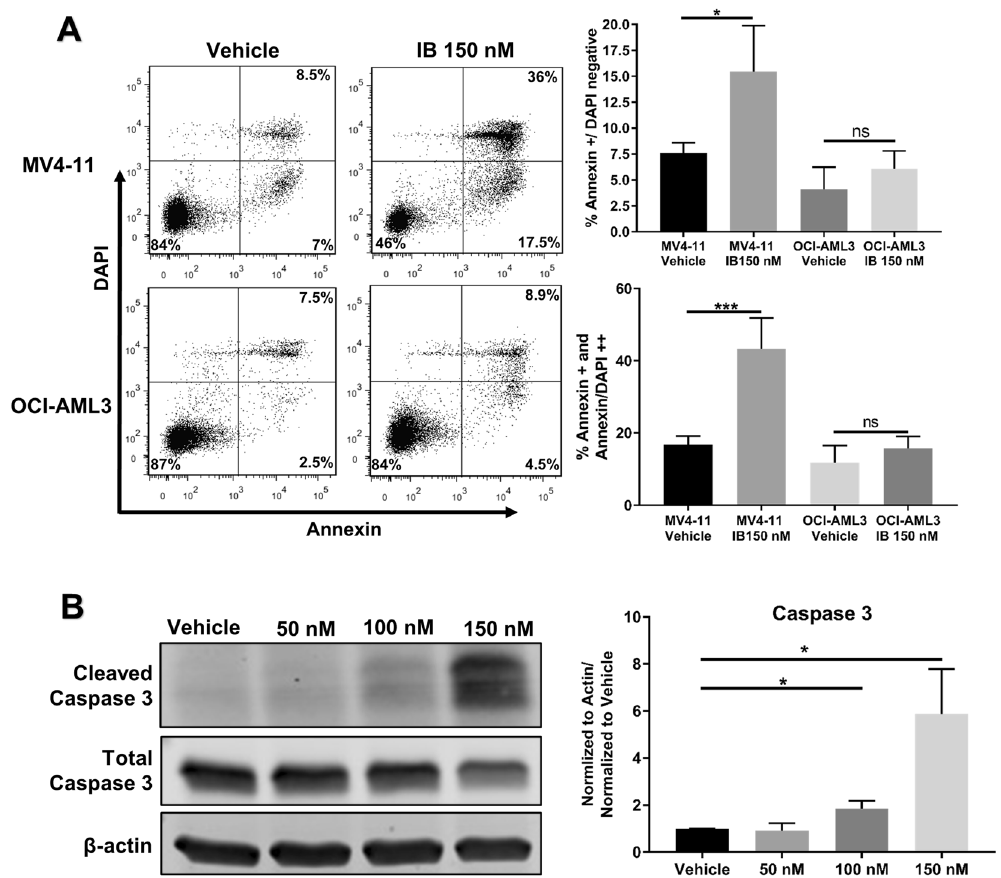
Figure 3. Imipramine blue targets FLT3/ITD + AML cells by inducing caspase 3 cleavage and apoptosis. ( A